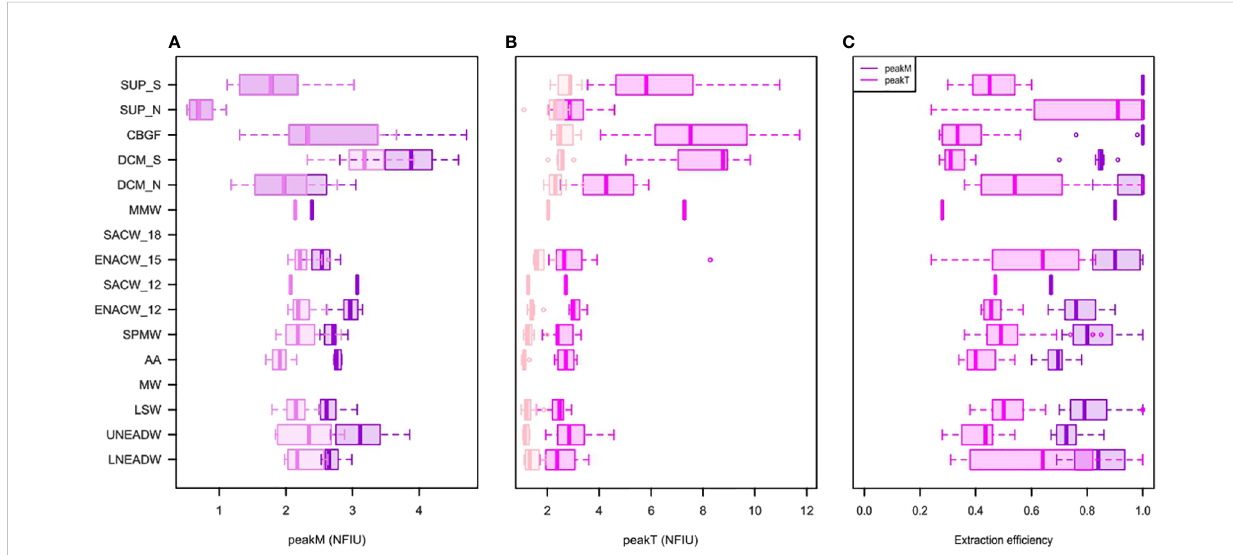
FIGURE 5 (A) peak M, and (B) peak T fl uorescence intensity of the bulk and SPE samples, and (C) the peak M and peak T extraction ef fi ciency, for each water body. Dark and light values represent bulk and SPE values, respectively. The boxes represent the interquartile range of the data, where the dark line represents the median. The whiskers represent the minimum and maximum values of the range, excluding the outliers, which are represent by dots. The y-axis represents the water bodies and WTs, water bodies were ordered by its position from the CVF: Waters south of CVF and Water north of CVF, while WTs were ordered by depth (Table S1) to obtain the water column pro fi le. Water bodies were: Surface North (SUP_N, 5.1 ± 0.4 Dbar), DCM North (DCM_N, 80.1 ± 17.0 Dbar), Surface South (SUP_S, 4.7 ± 0.7 Dbar), DCM South (DCM_S, 35.2 ± 15.0 Dbar) and The Cape Blanc Giant Filament (CBGF, 16.5 ± 15.9 Dbar). WTs were: Madeira Mode Water (MMW, 55.2 ± 21.2 Dbar), Eastern North Atlantic Central Water of 12°C (ENACW_12, 462.0 ± 63.1 Dbar) and 15°C (ENACW_15, 298.2 ± 14.4 Dbar), South Atlantic Central Water of 12°C (SACW_12, 345.3 ± 61.6 Dbar) and 18°C (SACW_18, 99.2 ± 55.8 Dbar), Subpolar Mode Water (SPMW, 749.3 ± 18.6 Dbar), Antarctic Intermediate Water (AA, 910.3 ± 101.4 Dbar), Mediterranean Water (MW, 1498.1 ± 54.5 Dbar), Labrador Sea Water (LSW, 1519.9 ± 44.5 Dbar) and the Upper (UNEADW, 3048.9 ± 141.4 Dbar) and Lower North East Atlantic Deep Water (LNEADW, 3822.6 ± 114.4